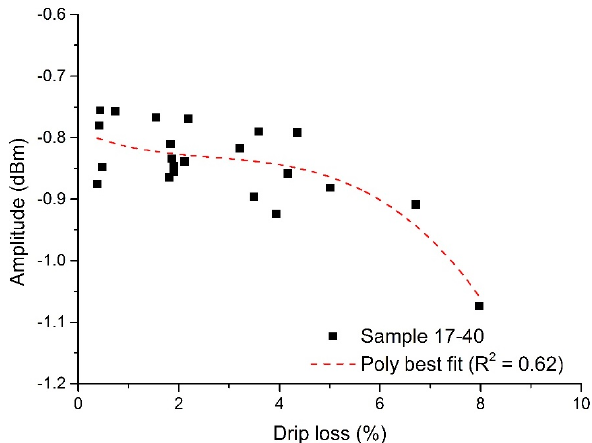
Figure 7. Correlation of the microwave cavity sensor at 4.23 GHz, with S 11 amplitude changing as a function of drip loss (R 2 = 0.62).